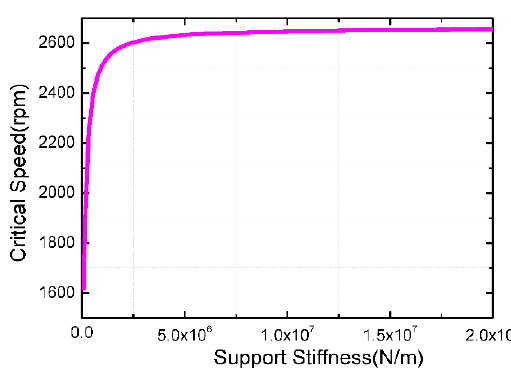
Figure 6. Influence of support stiffness on first order critical speed. Table 1. Different support stiffness levels corresponding to critical speed.